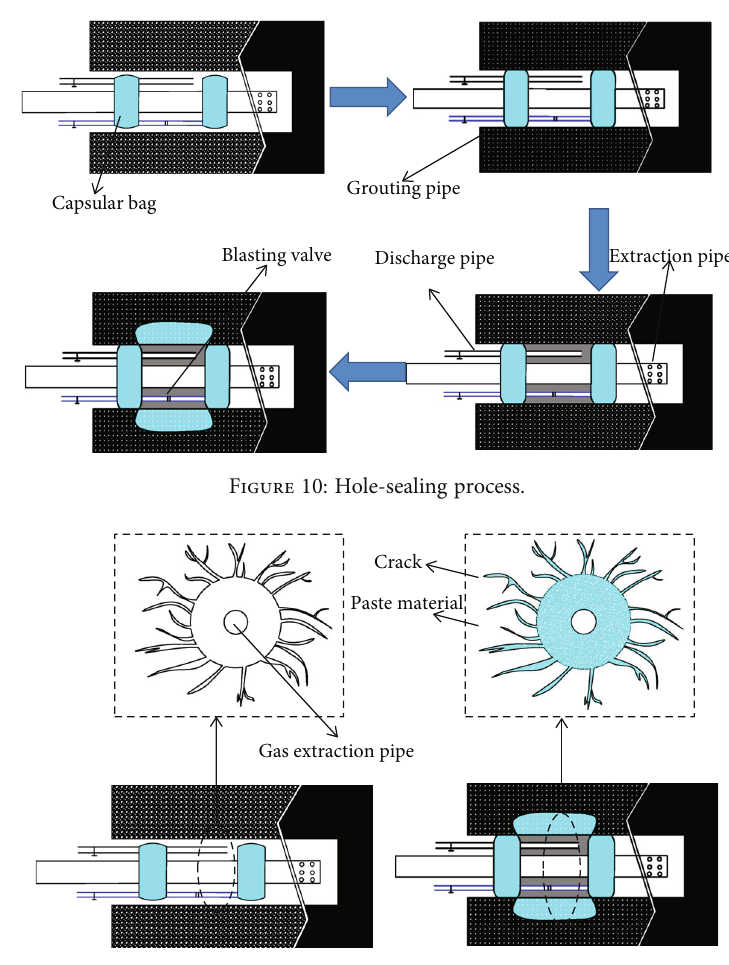
Figure 11: Comparison before and after grouting.